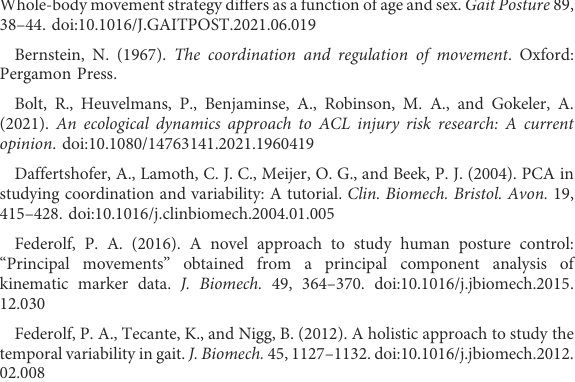
SUPPLEMENTARY FIGURE S1 Matrix group R of the correlation coef fi cients between Vicon group PM k and Vicon group PM k . Correlations were determined after separating PCA results back into individual matrices, coef fi cients shown here represent the mean absolute correlation coef fi cients averaged over the entire subject